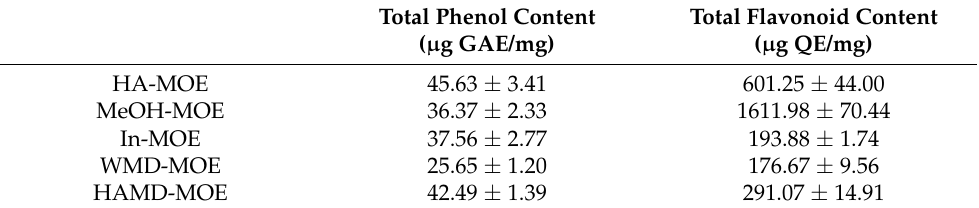
Table 2. Total phenol and flavonoid content of leaf extracts of M. oleifera Lam.